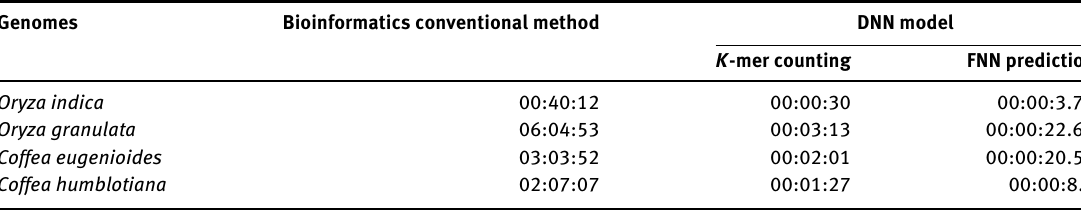
Table 4: Execution time of the conventional method and the model implemented for LTR_STRUC data. Genomes